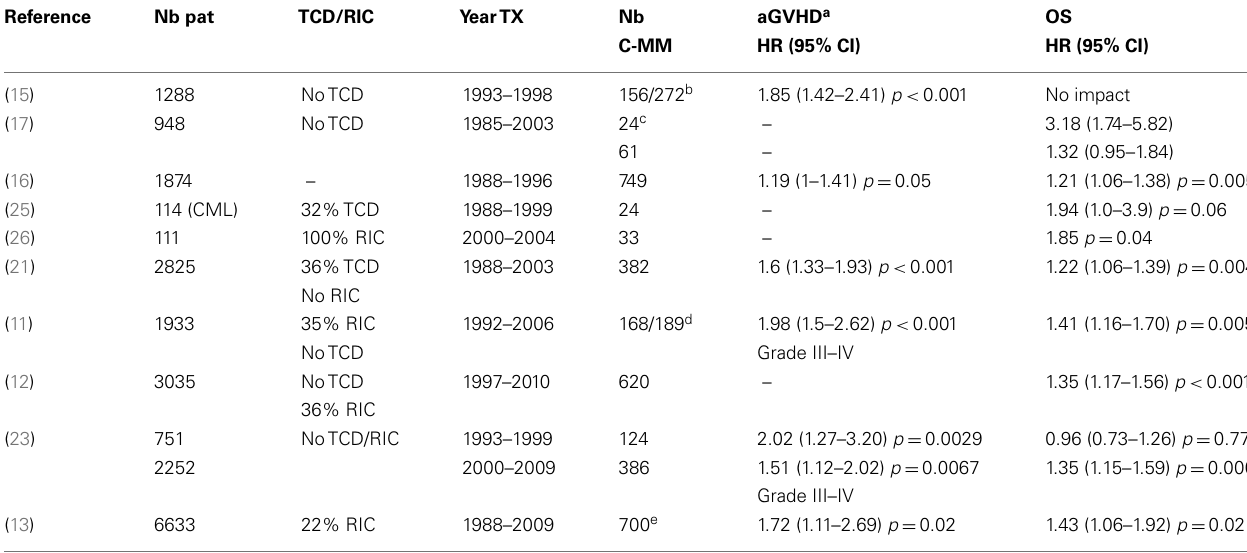
Table 2 | Hazard ratios for two outcomes in nine HSCT cohorts with single HLA-C mismatches . Reference